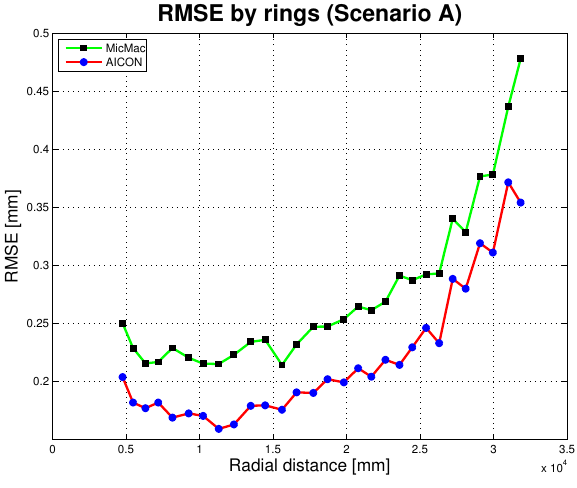
Figure 5: RMSE computed for each ring of targets, identified by their radial distance, for Scenario A. tions of error (Figure 8: middle for AICON 3D Studio, bottom for MicMac), which mirror the RMSE performances. In fact, the area containing “blue” targets (points estimated with higher precision) is more extended for AICON 3D Studio than MicMac, where the estimate of the target positions seems to be affected by the non homogeneous distribution of homologous ray